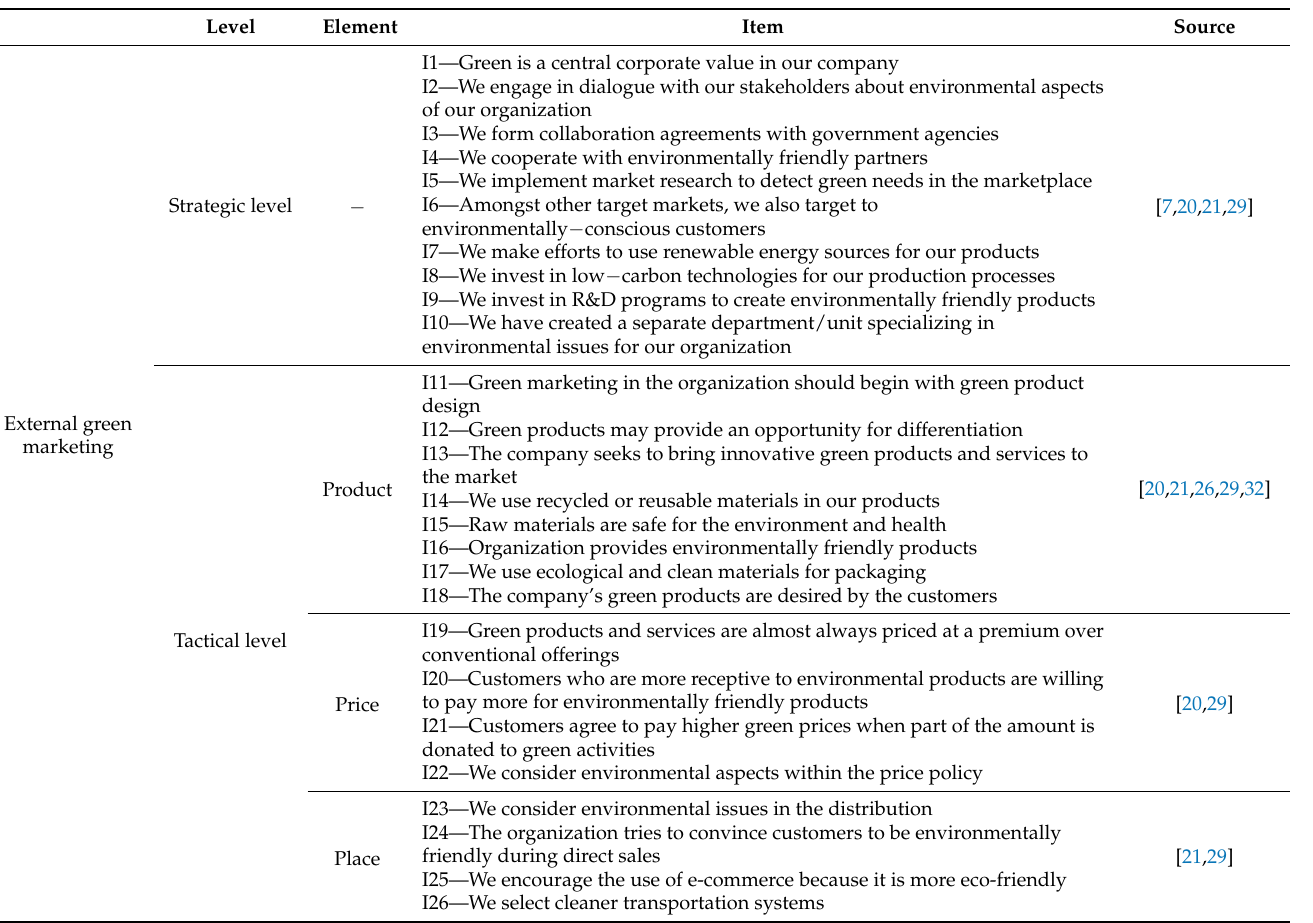
Table A1. The initial version of the Green Marketing